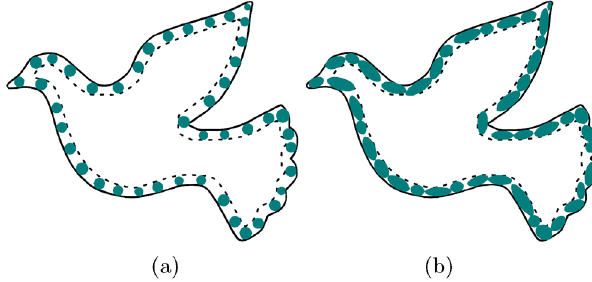
Fig. 3 Initial ellipse packing. We uniformly sample circles inside the pipe (a), and deform each into an ellipse until it touches its neighbour or the pipe boundary at more than two points (b).